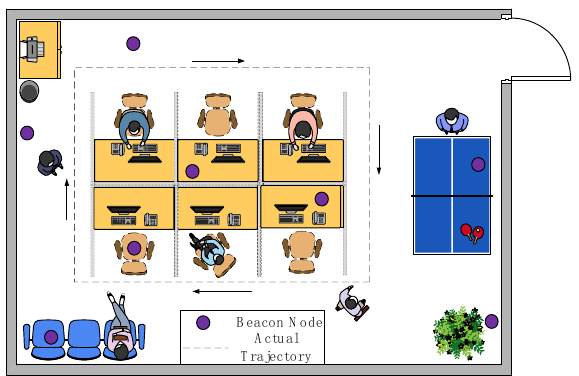
Figure 11. The placement of the beacon nodes and the actual mobile node trajectory.